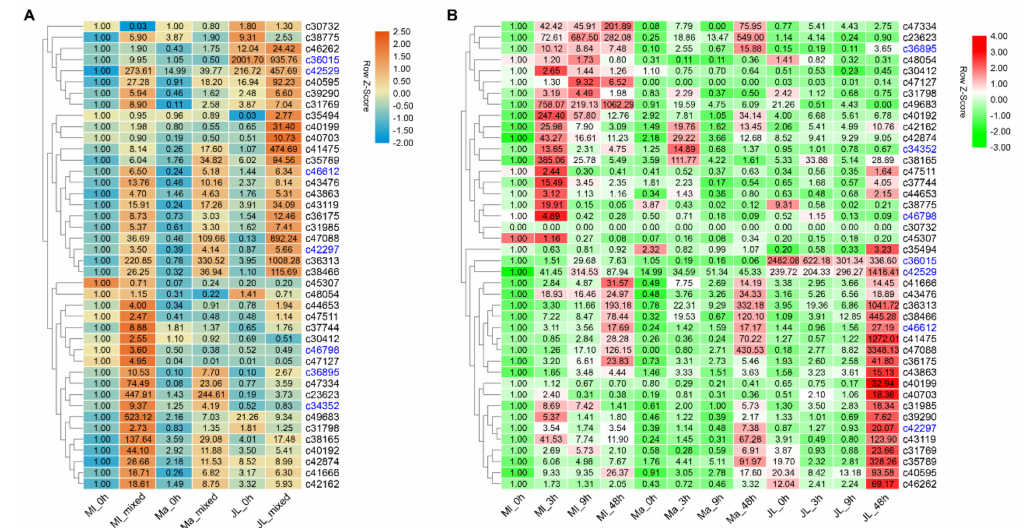
Figure 6. The expression patterns of the 42 candidate genes in di ff erent varieties of mulberry. ( A ) The expression patterns of the 42 candidate genes in the mixed samples at di ff erent stages after infection in di ff erent varieties. ( B ) The expression patterns of the 42 candidate genes at di ff erent stages after infection in di ff erent varieties. The gene expression analysis was examined by qRT-PCR, and all of the qRT-PCR values were expressed relative to the expression level of Ml_0h. The expression patterns represented by the bar charts are shown in Figures S2 and